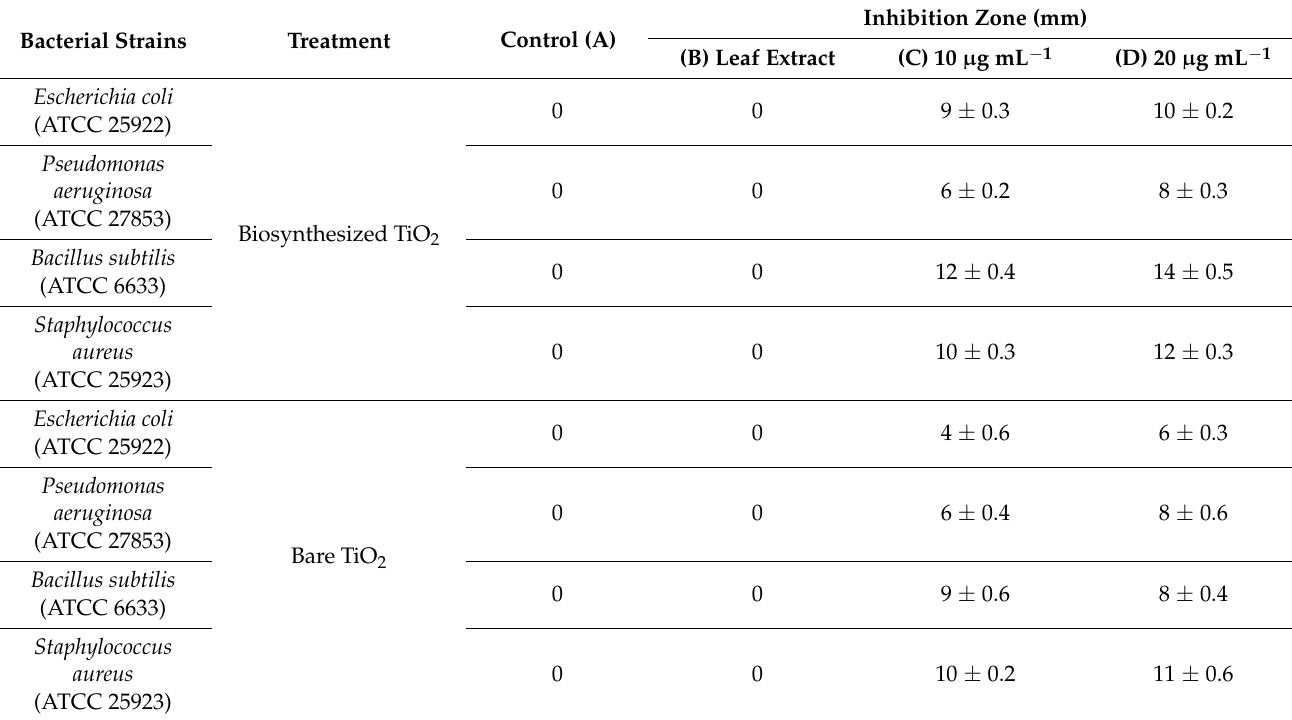
Table 2. Disc diffusion analysis of biosynthesized TiO 2 nanoparticles: (A) control (B) leaf